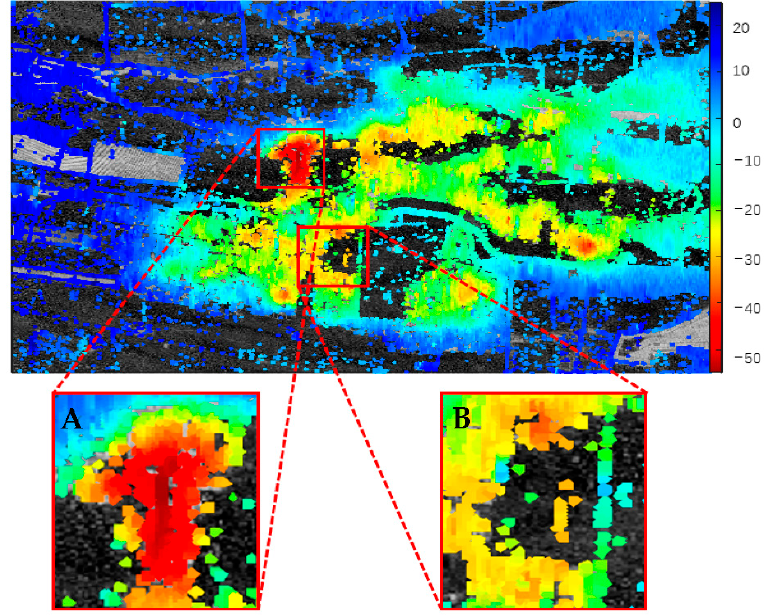
Figure 15. The land deformation estimated using the proposed method . ( A ) Site A, ( B ) Site